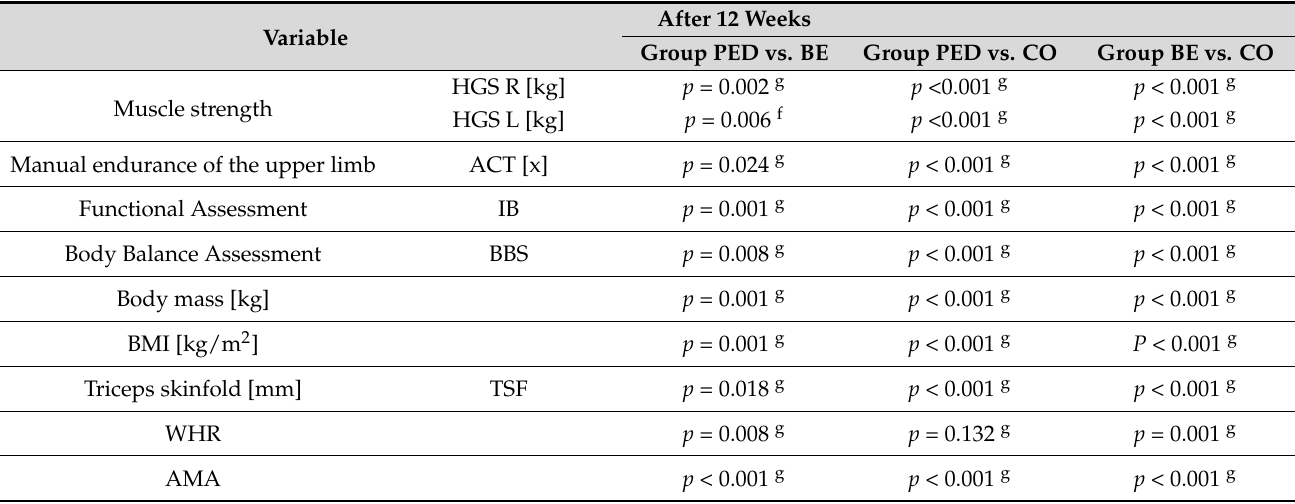
Table 4. Between-group comparisons of changes after 12